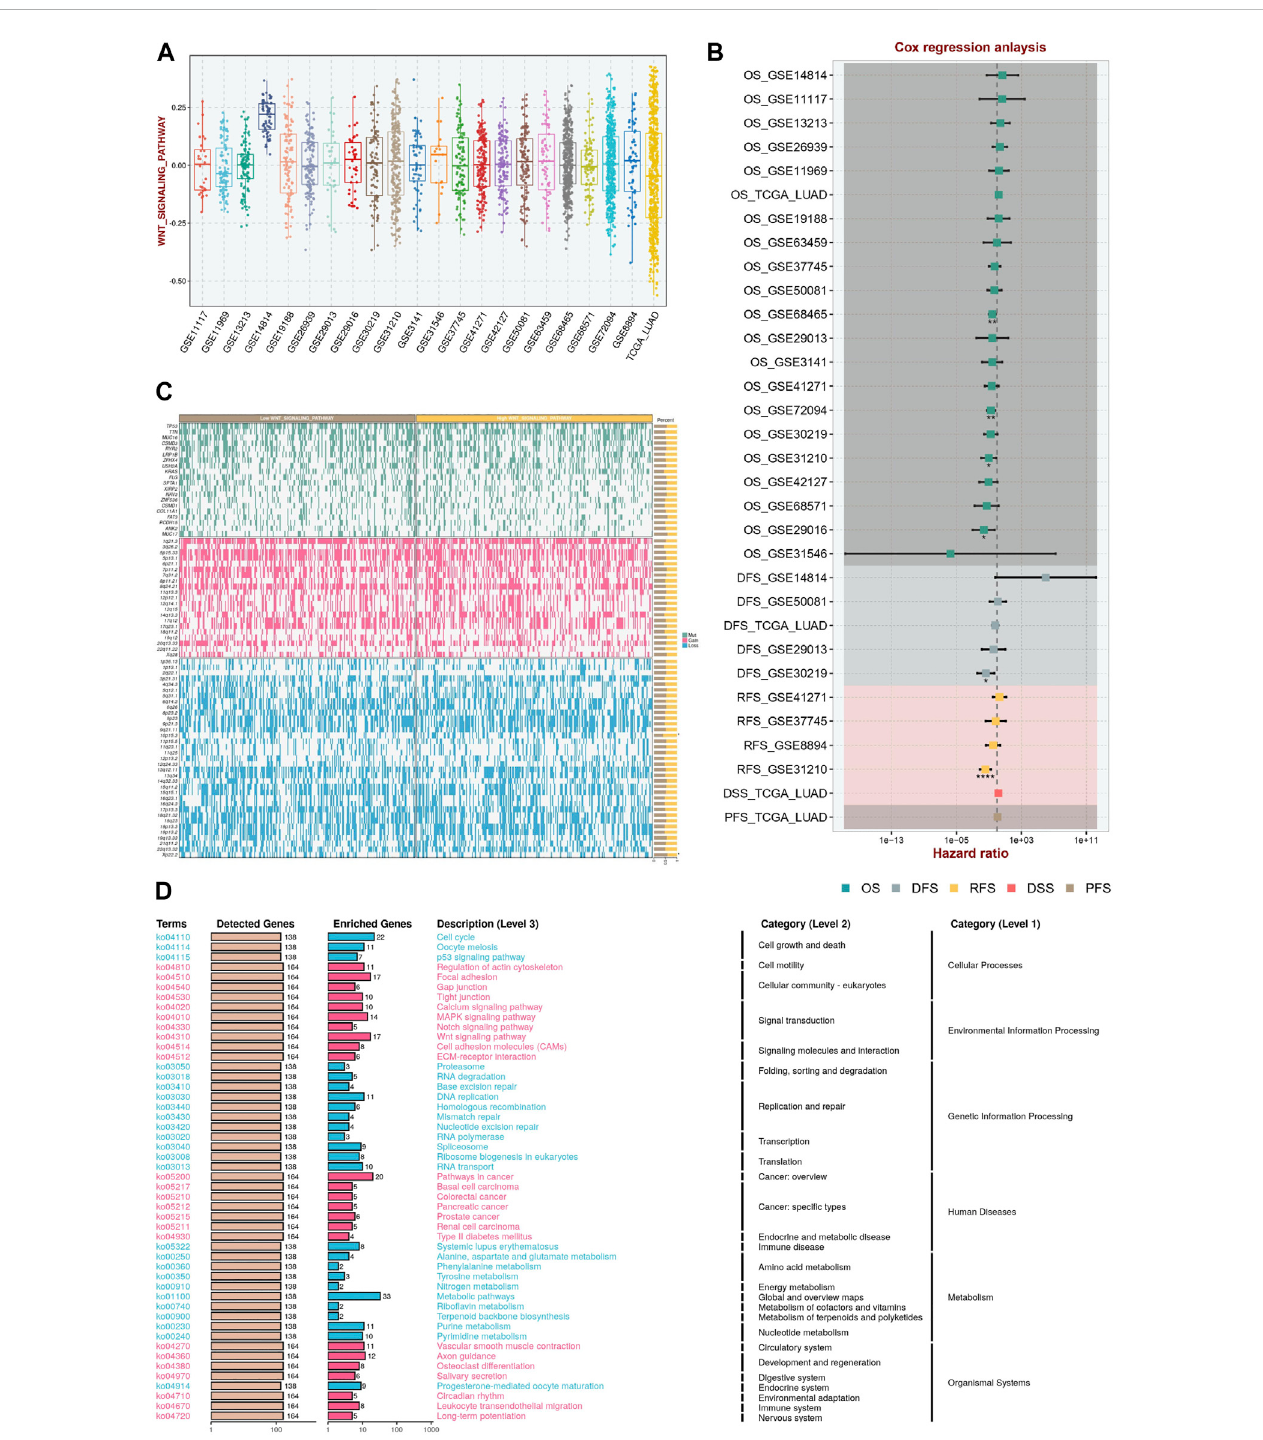
FIGURE 1 Wnt Signaling Score Based on ssGSEA in the Multicenter Study. (A) The Wnt signaling pathway absolute enrichment score based ssGSEA in different datasets. (B) Cox regression analysis in multicenter study demonstrated that Wnt scores had prognostic value. (C) The mutational landscape in different Wnt groupings. (D) The activation pathways in different Wnt